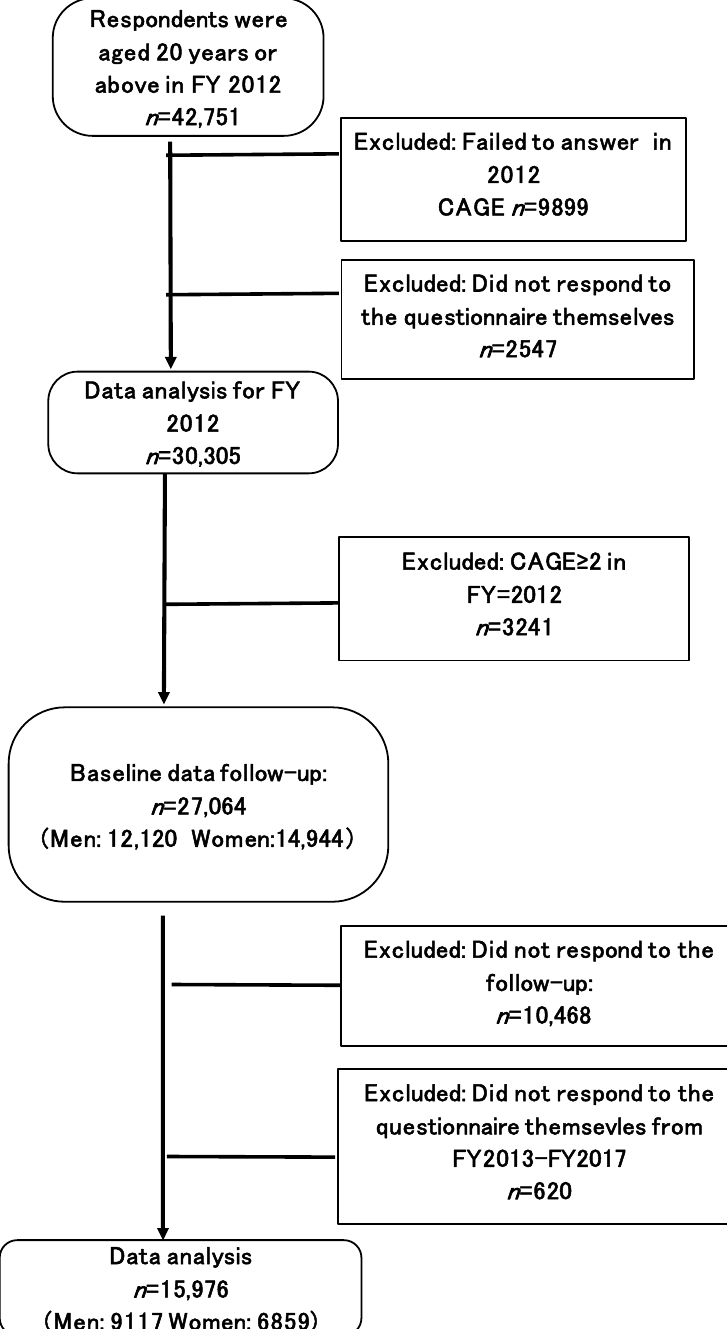
Figure 1. Participant flow chart (CAGE < 2 in 2012).